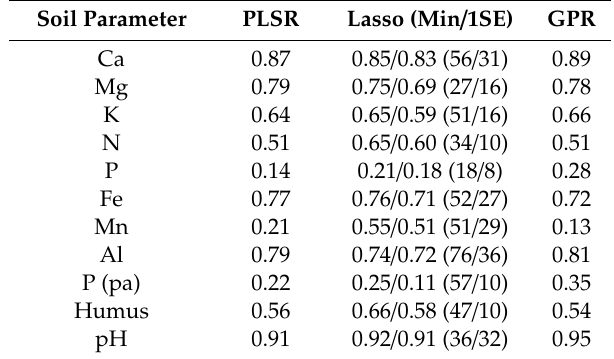
Table 2. Comparison of coe ffi cients of determination of PLSR, Lasso and GPR methods, number of Lasso coe ffi cients (Min / 1SE) in parenthesis.